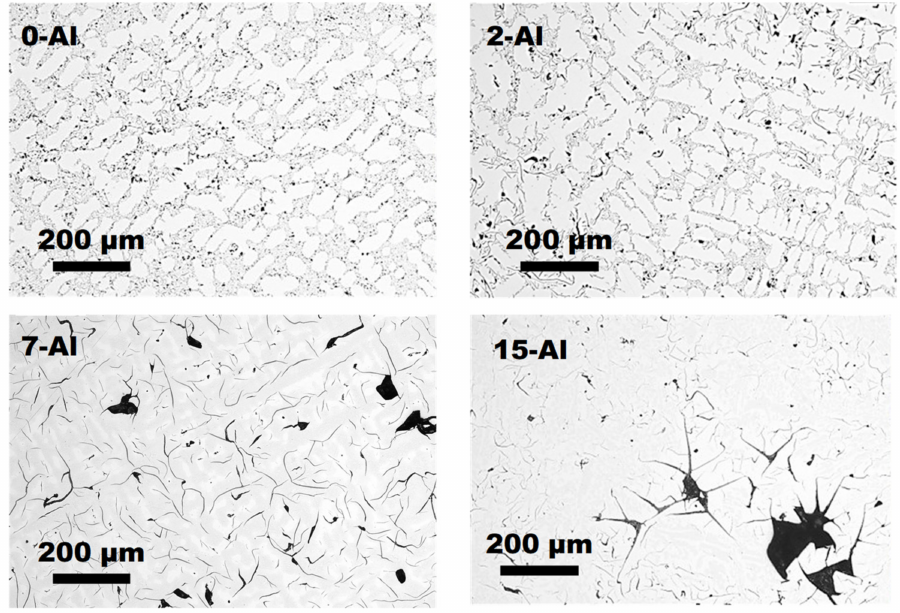
Figure 4. Effect of Al on the graphite morphology in the microstructure of alloys containing 0 wt.%, 2 wt.%, 7 wt.% and 15 wt.%